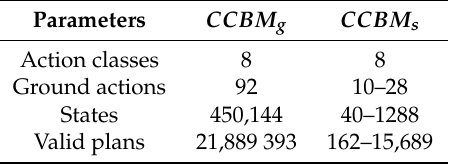
Table 6. Parameters for the different